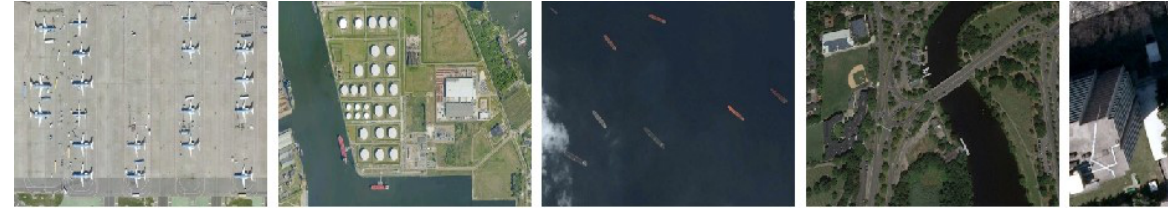
Figure 5. Samples of the constructed dataset.